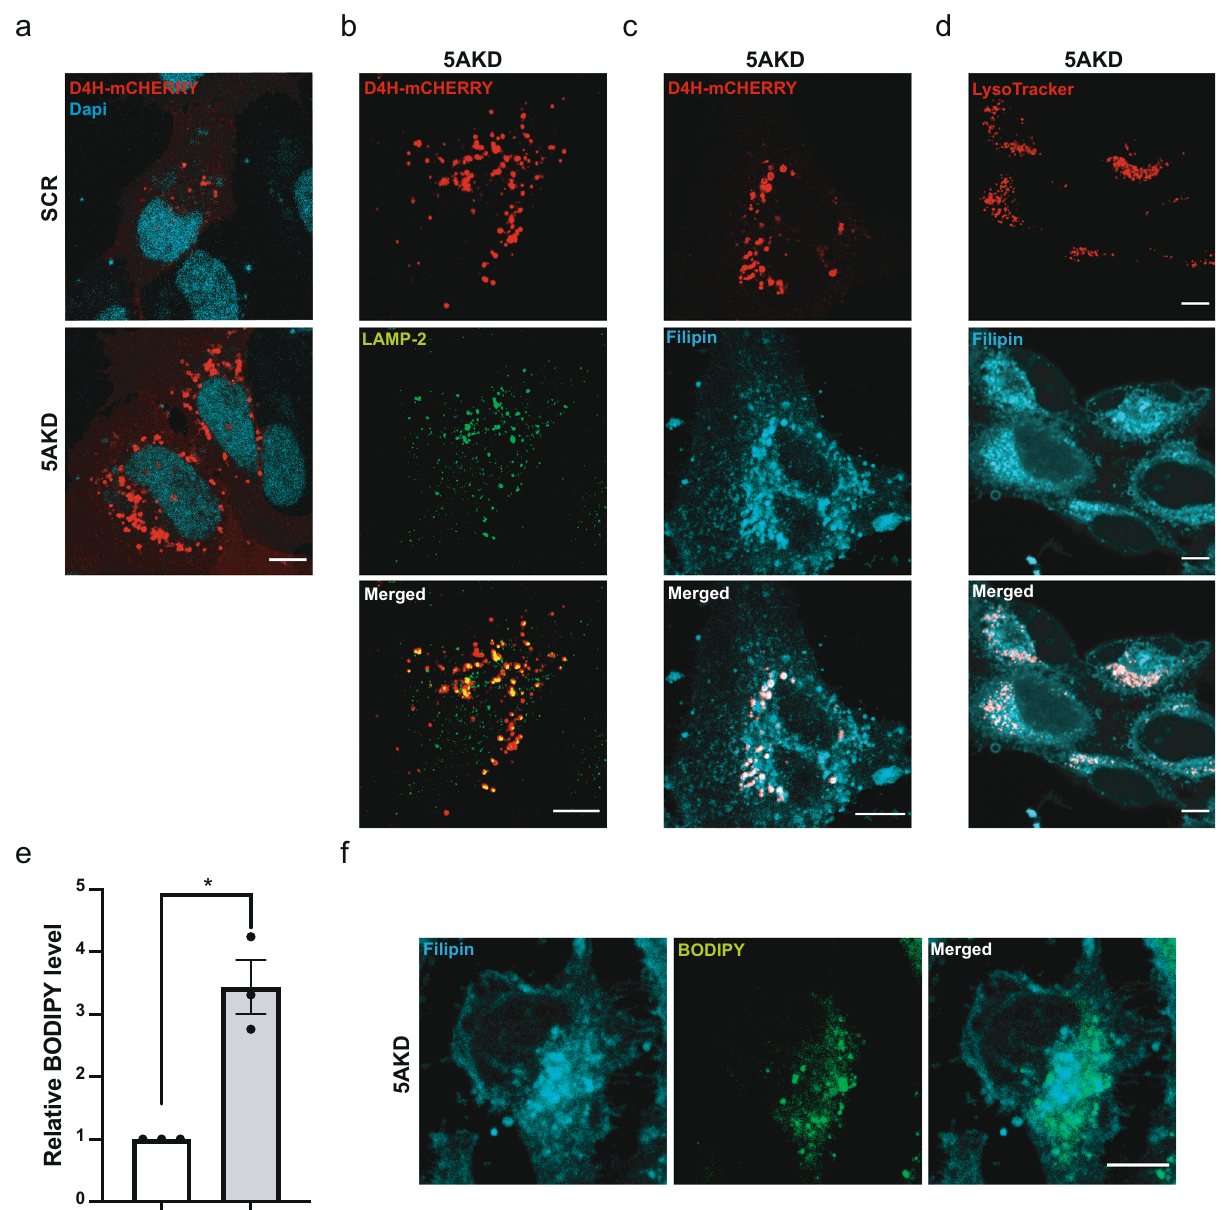
Fig. 4 In the absence of INPP5A cholesterol is directed towards lysosomes and lipid droplets. a Representative images from three independent experiments of HeLa cells treated with control (SCR) or INPP5A siRNA (5AKD) and transfected with a plasmid encoding D4H-mCherry (red) to detect intracellular cholesterol, Blue, DAPI-stained nuclei. Scale bar, 10 μ m. b Representative images from three independent experiments of HeLa cells treated with INPP5A siRNA (5AKD), transfected with a plasmid encoding D4H-mCherry (red) to detect intracellular cholesterol, and stained with anti-LAMP-2 (green) antibodies to label lysosomes. Scale bar, 10 μ m. c Representative images from three independent experiments of HeLa cells treated with INPP5A siRNA (5AKD), transfected with a plasmid encoding D4H-mCherry (red) to detect intracellular cholesterol, and incubated for 45 min post- fi xation with 0.05 mg/ml Filipin (cyan). Scale bar, 10 μ m. d Representative images from two independent experiments of HeLa cells treated with INPP5A siRNA (5AKD), incubated with Lysotracker (red, 1:1000 dilution) for 60 min before fi xation to stain lysosomes, and incubated for 45 min post- fi xation with 0.05 mg/ml Filipin (cyan). Scale bar, 10 μ m. e Relative BODIPY 493/503 (4,4-Di fl uoro-1,3,5,7,8-Pentamethyl-4-Bora-3a,4a-Diaza-s-Indacene) levels incubated for 15 min with 2 μ M as a measure for lipid droplets in HeLa cells treated with control (SCR) or INPP5A siRNA (5AKD). One sample t -test: 5AKD: p = 0.03, t = 5.642, df = 2. f Representative images from three independent experiments of HeLa cells treated with INPP5A siRNA (5AKD) and incubated for 15 min with 2 μ M of BODIPY (green) before fi xation and incubated for 45 min post- fi xation with 0.05 mg/ml Filipin (cyan) Scale bar, 10 μ m. All data represent mean ± SEM from three independent experiments. Numerical source data are reported in the Source Data fi